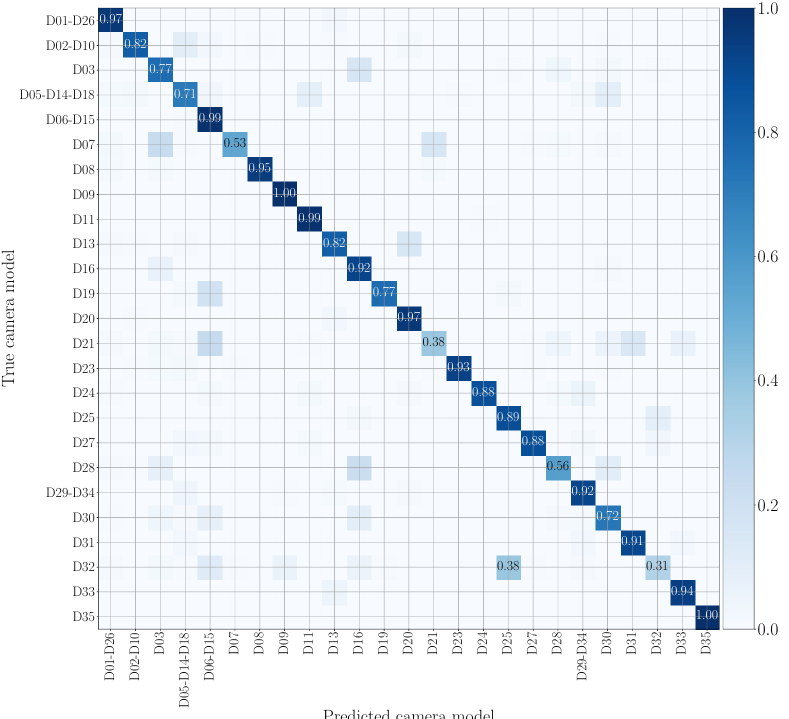
Figure 11. Confusion matrix achieved by multi-modal camera model identification exploiting Early Fusion EV. We report results by training and testing on the native video set, and we only show the numbers which exceed 0.3. Device nomenclature is that of